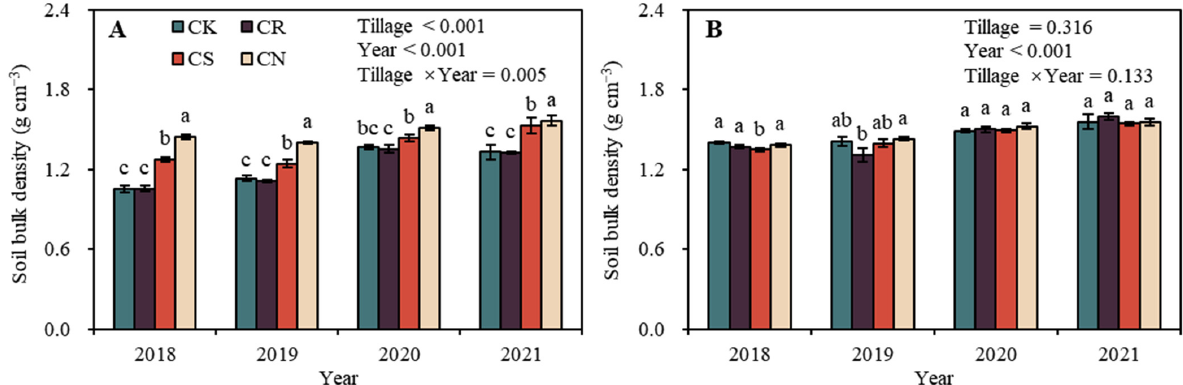
Figure 3. Soil bulk density at 0–20 cm ( A ) and 20–40 cm ( B ) soil depths as affected by tillage regimes during 2018 to 2021. CK, rotary tillage without straw returning; CR, rotary tillage with straw incor ‐